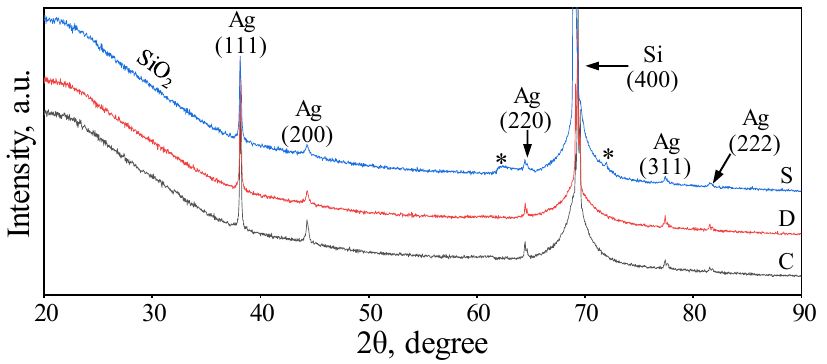
Figure 4. XRD patterns of SiO 2 (Ag)/Si with different morphology of silver: (C, crystallites; S, "sun- flowers"; D, dendrites).